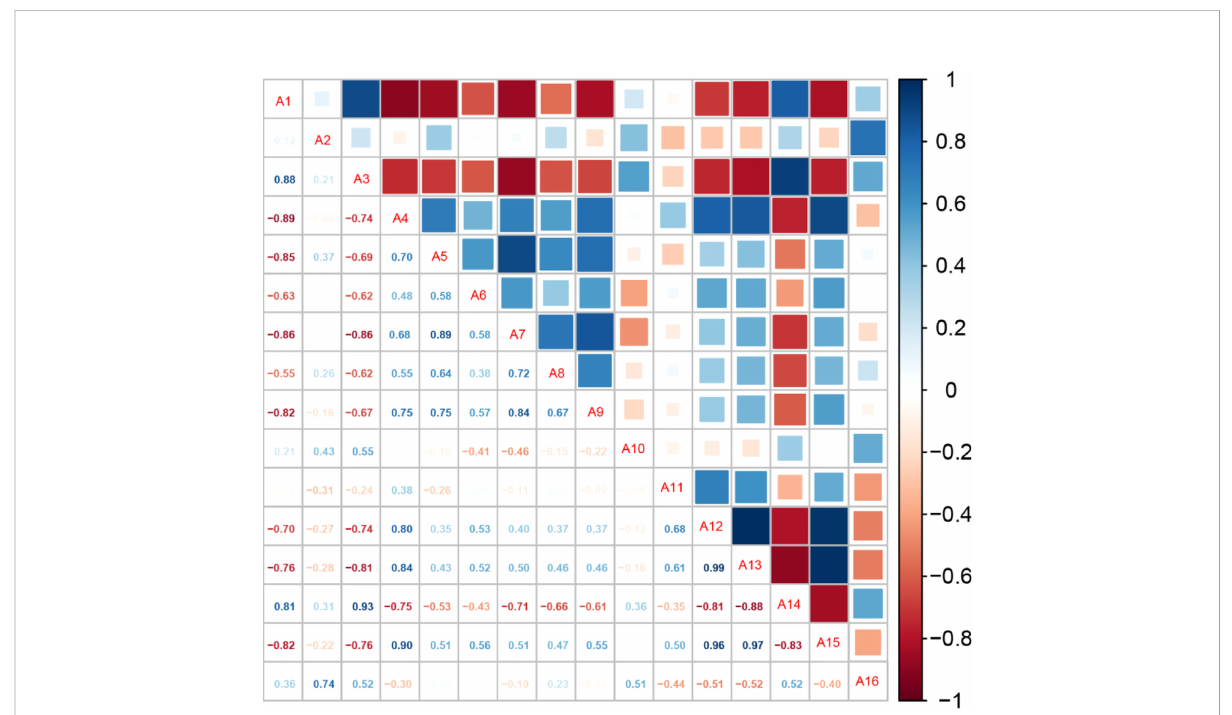
FIGURE 4 Correlation analysis among the indicators of Pepino under different light treatments. A1: percentage of blue light; A2: number of lateral branches; A3: length of lateral branches; A4: plant height; A5: aboveground dry weight; A6: number of leaves; A7: leaf area of the whole plant; A8: stem diameter; A9: internode length; A10: sucrose synthetase; A11: sucrose phosphate synthase; A12: Chl a; A13: Chl b; A14: Chl a/b; A15: carotenoids; A16: soluble